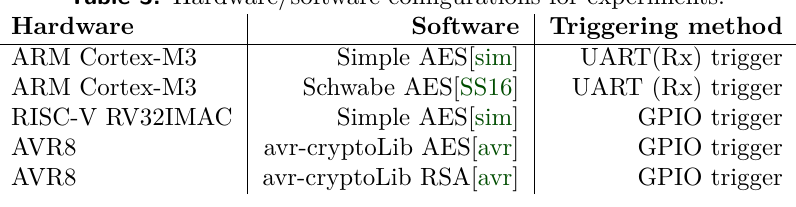
Table 3: Hardware/software configurations for experiments.